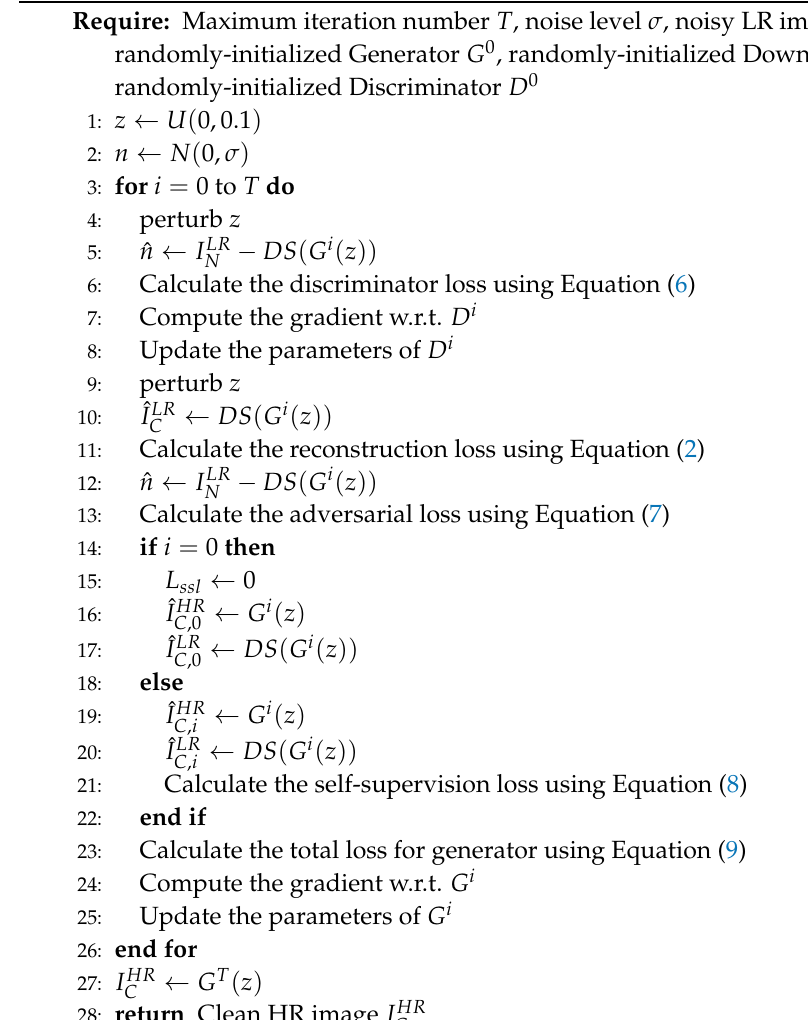
Algorithm 1: Training scheme of proposed